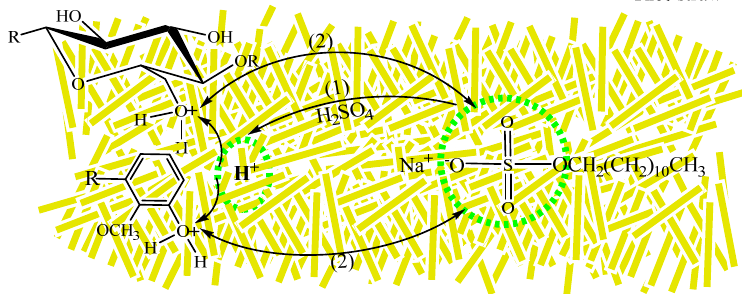
Figure 1. Mechanism of composite surface modi fi cation .